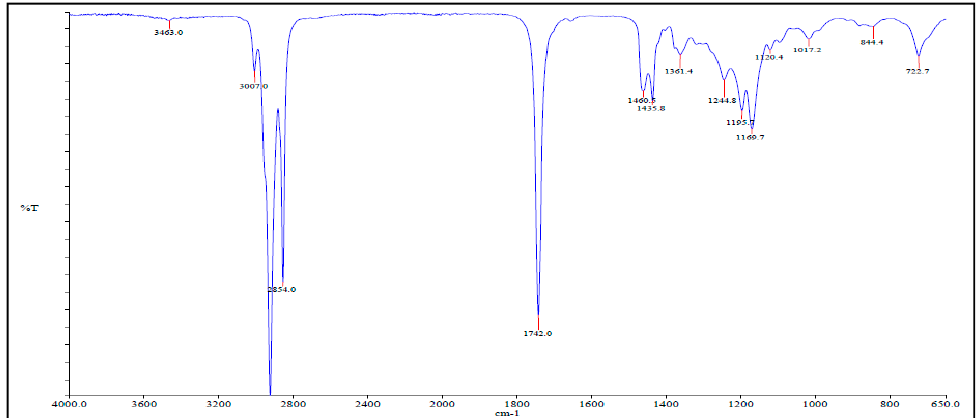
Figure 4. Fourier transforms infrared (FTIR) spectrum of SFO biodiesel.